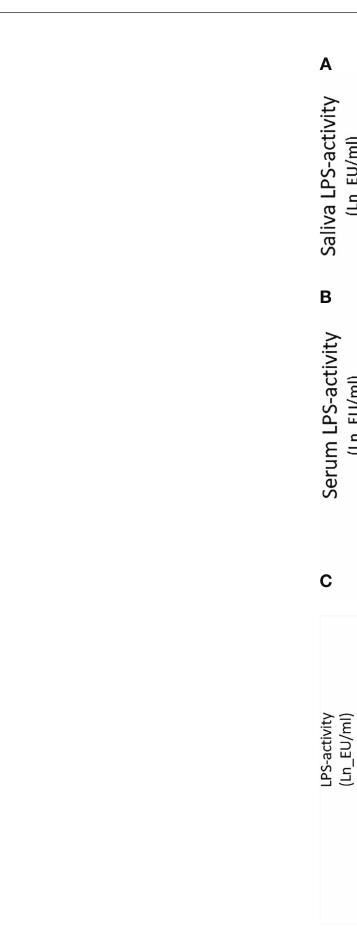
TABLE 5 | Association of antibiotic type with subgingival phyla.